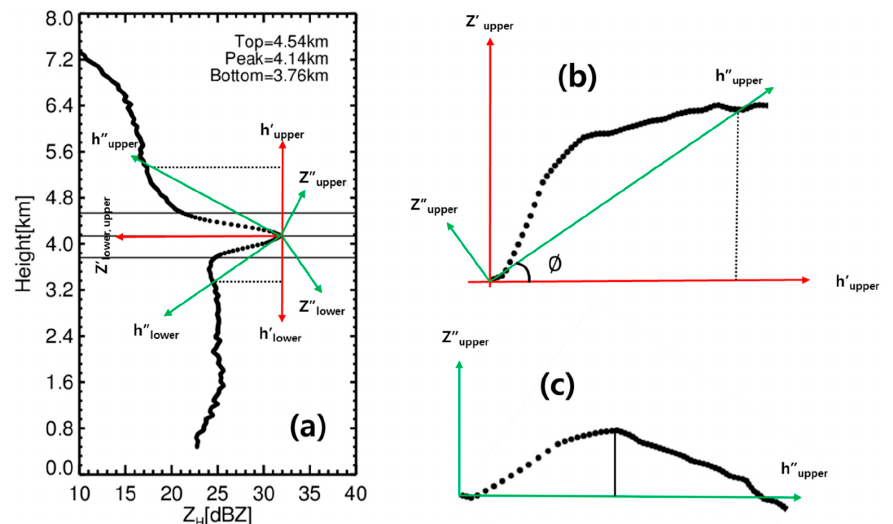
Figure 2. Quasi-vertical profile (QVP) of the Z H and the parameters defined for rotating coordinates. ( a ) Original coordinate; ( b ) New coordinate after 90° rotation; ( c ) Final coordinate after ∅ degree rotation. The thin lines indicate the top, peak, and bottom of the bright band (BB) derived from the QVP of the Z H . Remote Sens. 2020 , 12 , x